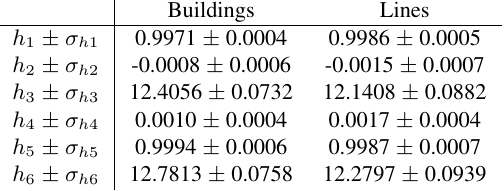
Table 1: Estimated affine parameters for LiDAR DSM and HSI using extracted building outlines and lines. Estimated affine parameters for LiDAR DSM - HSI coregistra-